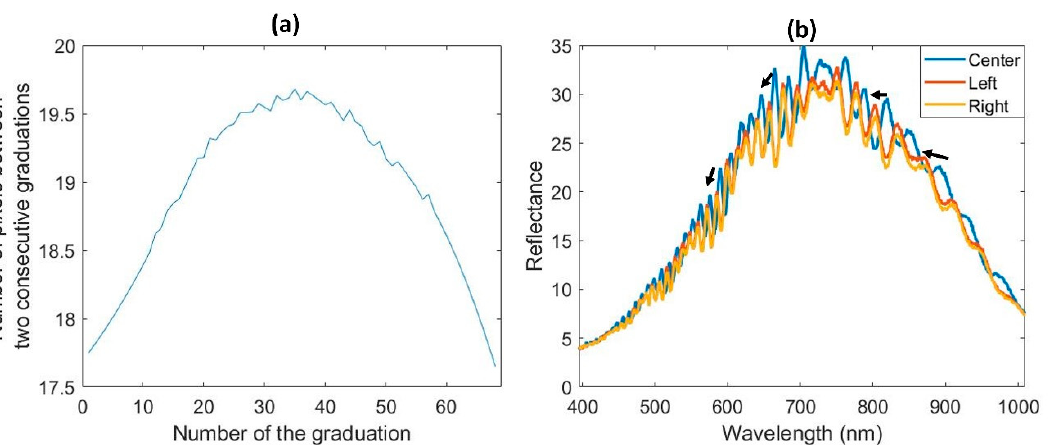
Figure 7. Aberrations ( a ) geometric (number of pixels between two successive graduations of a ruler) and ( b ) wavelength shifts (spectra at different positions of a white reference) when using the OLE23 lens of the VNIR PFD65-V10E camera (Specim).